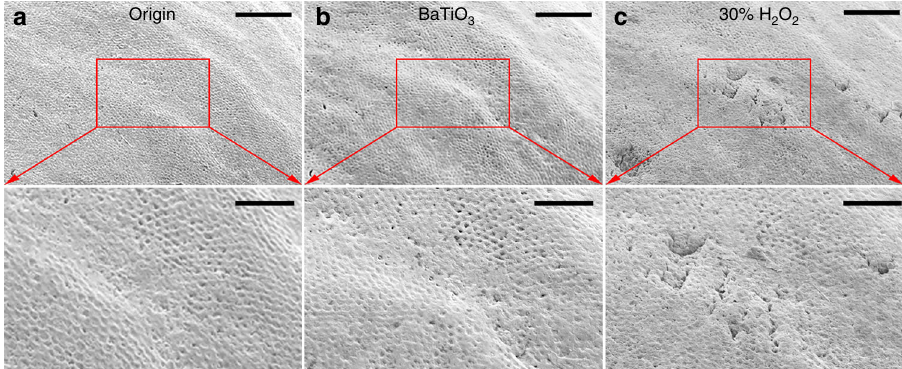
Fig. 5 Nondestructive characterization. The scanning electron microscope images of an identical tooth a before whitening treatment, b after piezo- catalysis whitening in BTO turbid liquid for 3 h, and c after further whitening by 30% H 2 O 2 for 2 h. The images at the bottom are the enlarged view of the marked identical zone. Scale bars are 100 μ m (top) and 50 μ m